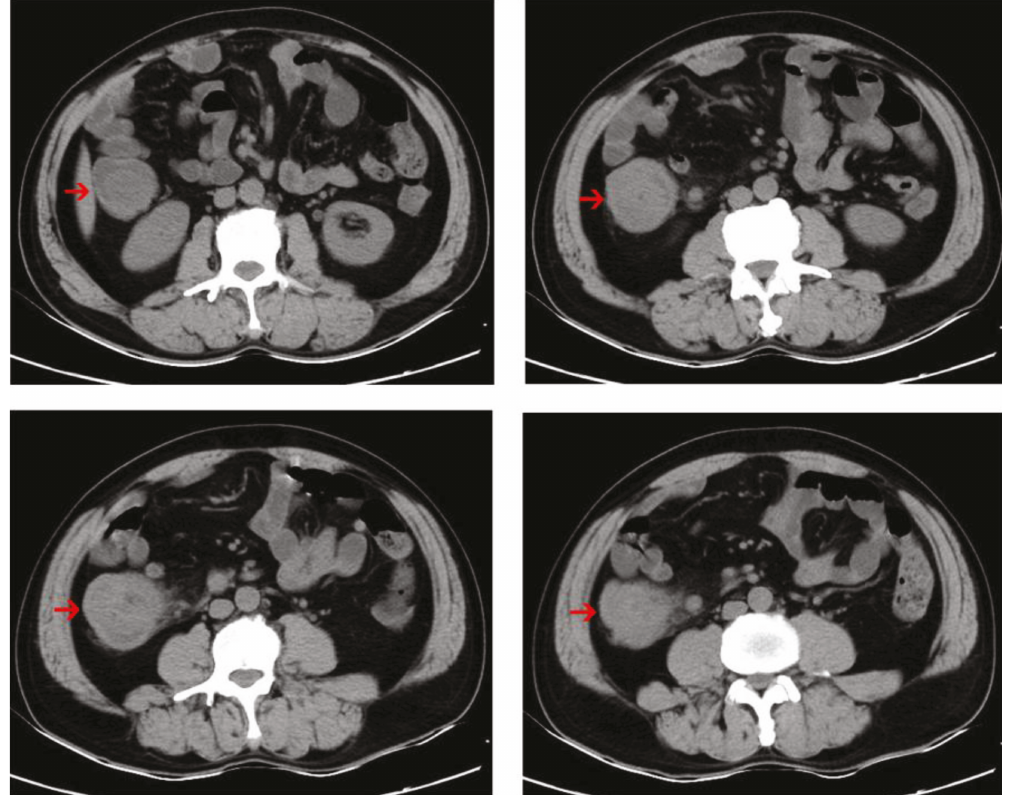
Figure 2: Abdominal CT of Case 9 showing an ascending colon mass and surrounding lymph node enlargement, which was suggestive of the possibility of colon cancer.